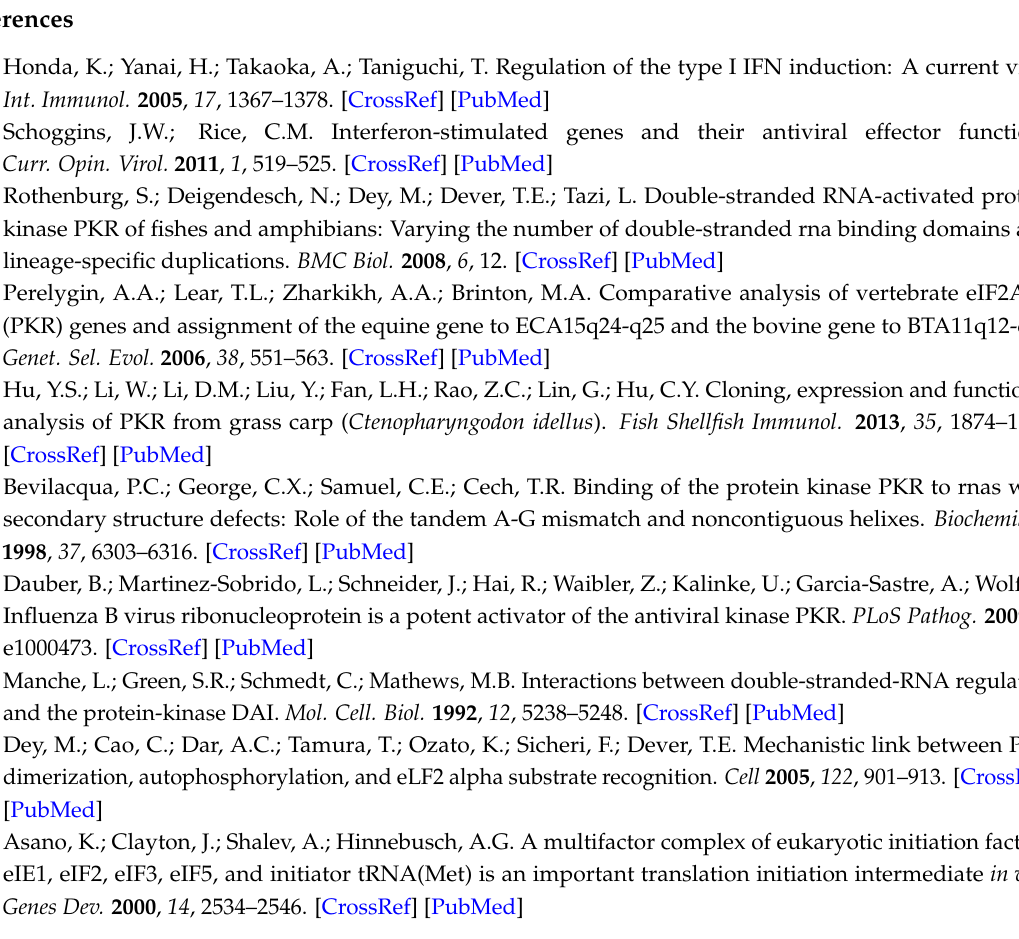
Figure S1: mutcarpPKR effect on IPNV titer in EPC